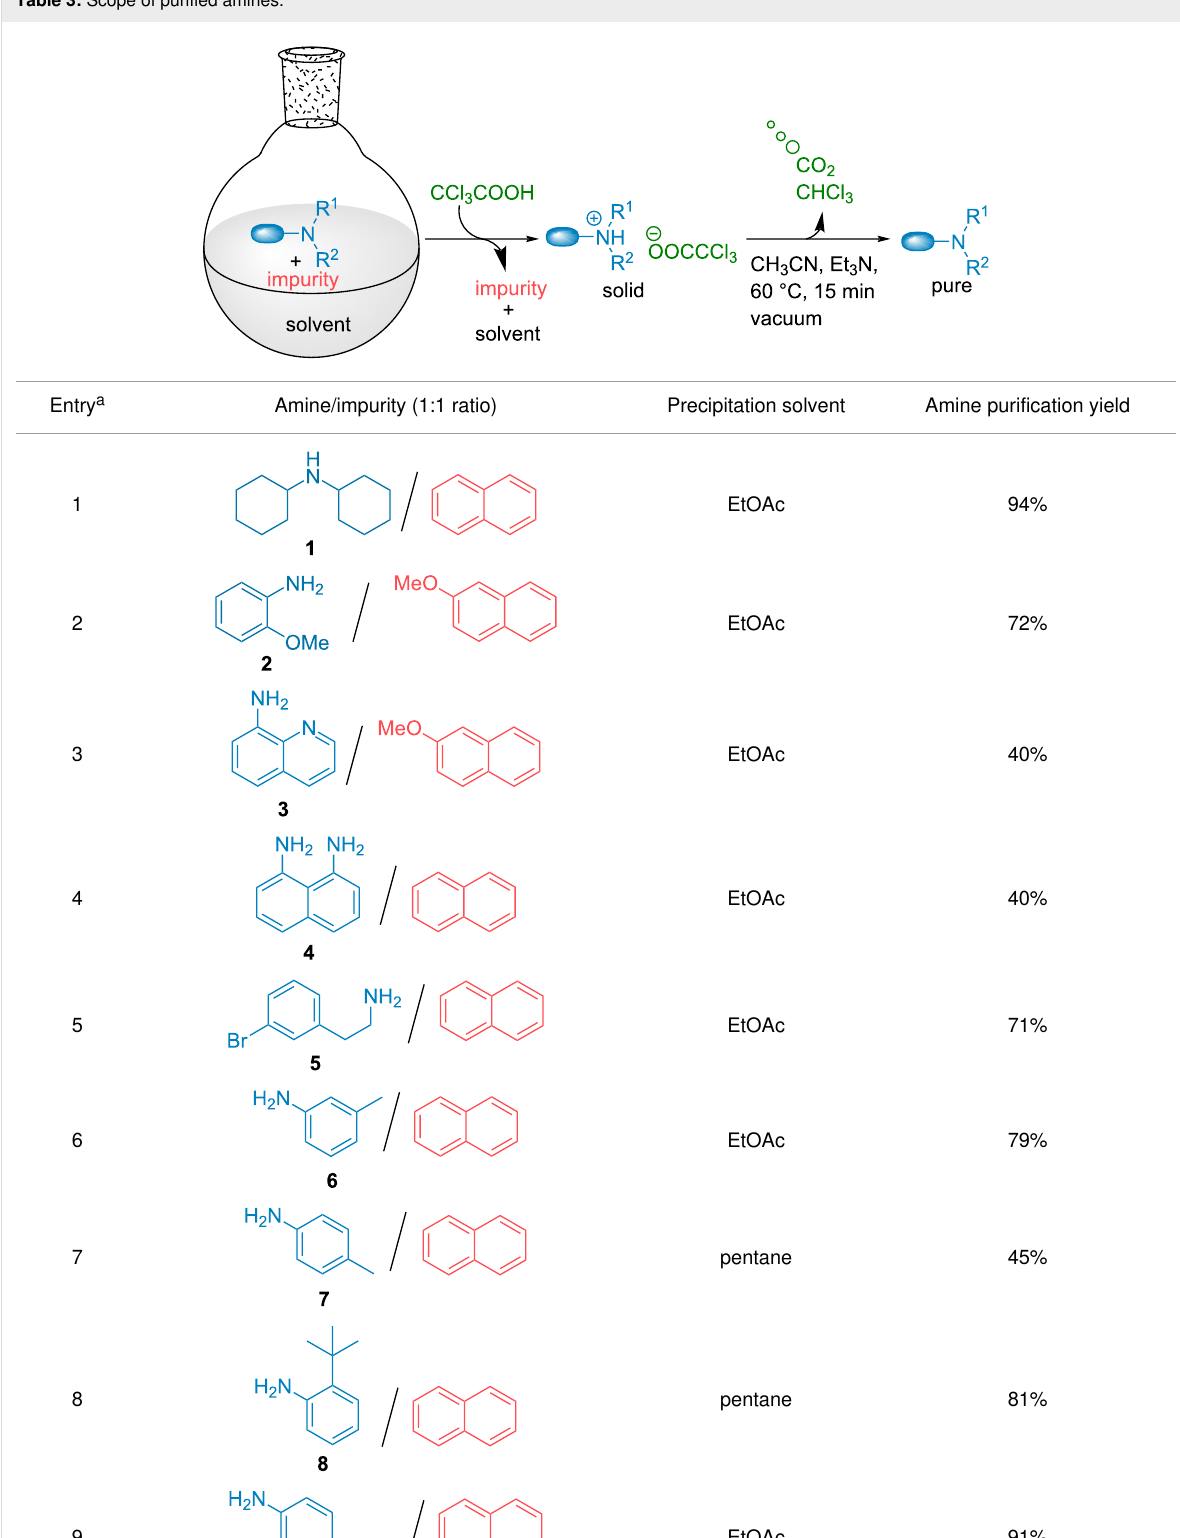
Table 3: Scope of purified